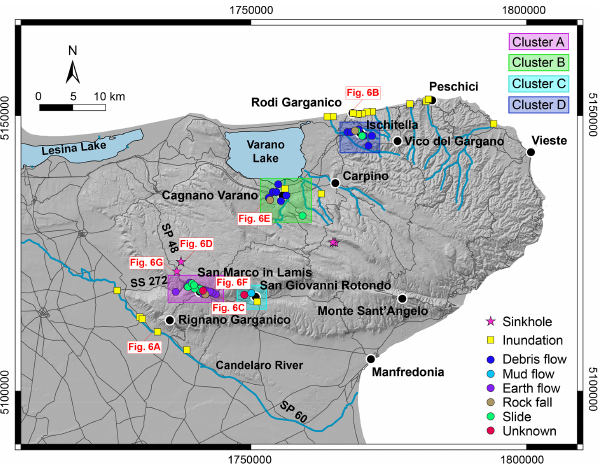
Figure 5. Map showing location of event landslides, floods and sinkholes triggered by the 1–6 September 2014 intense rain- fall event in the Gargano Promontory. WGS84/Pseudo Mercator